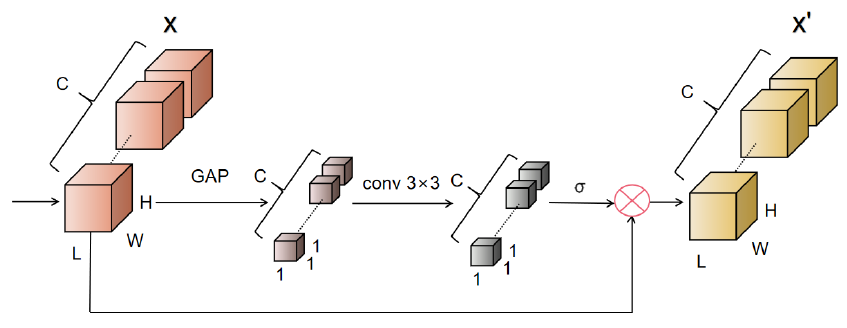
Figure 4. Scheme of the proposed channel interaction unit